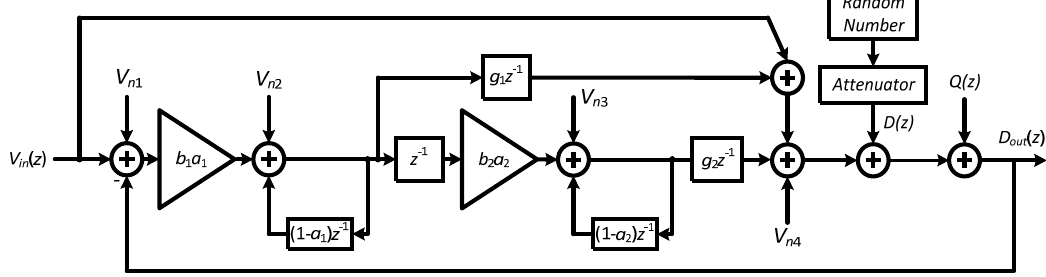
Figure 8. Signal flow diagram of the 2nd ‐ order noise shaping (NS) Δ Ʃ SAR ADC.